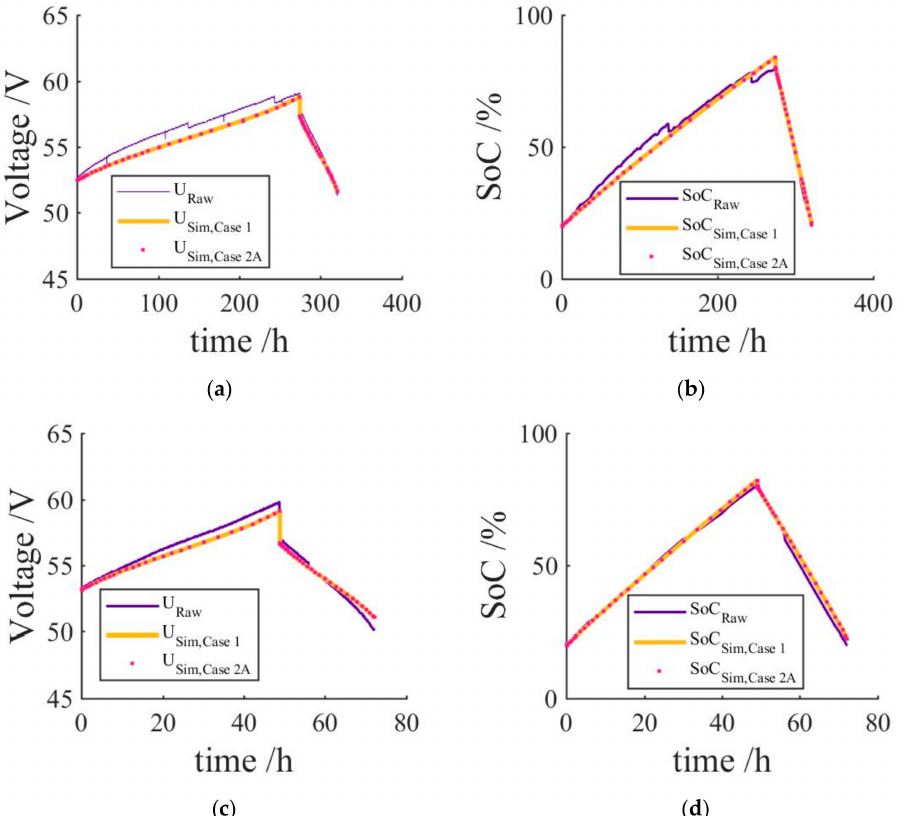
Figure 1. Comparison between simulation model and measurements using fitting Case 1 and Case 2A: ( a ) Voltage with P apl = 1kW; ( b ) SoC with P apl = 1kW; ( c ), Voltage with P apl = 2.5kW; ( d ) SoC with P apl =